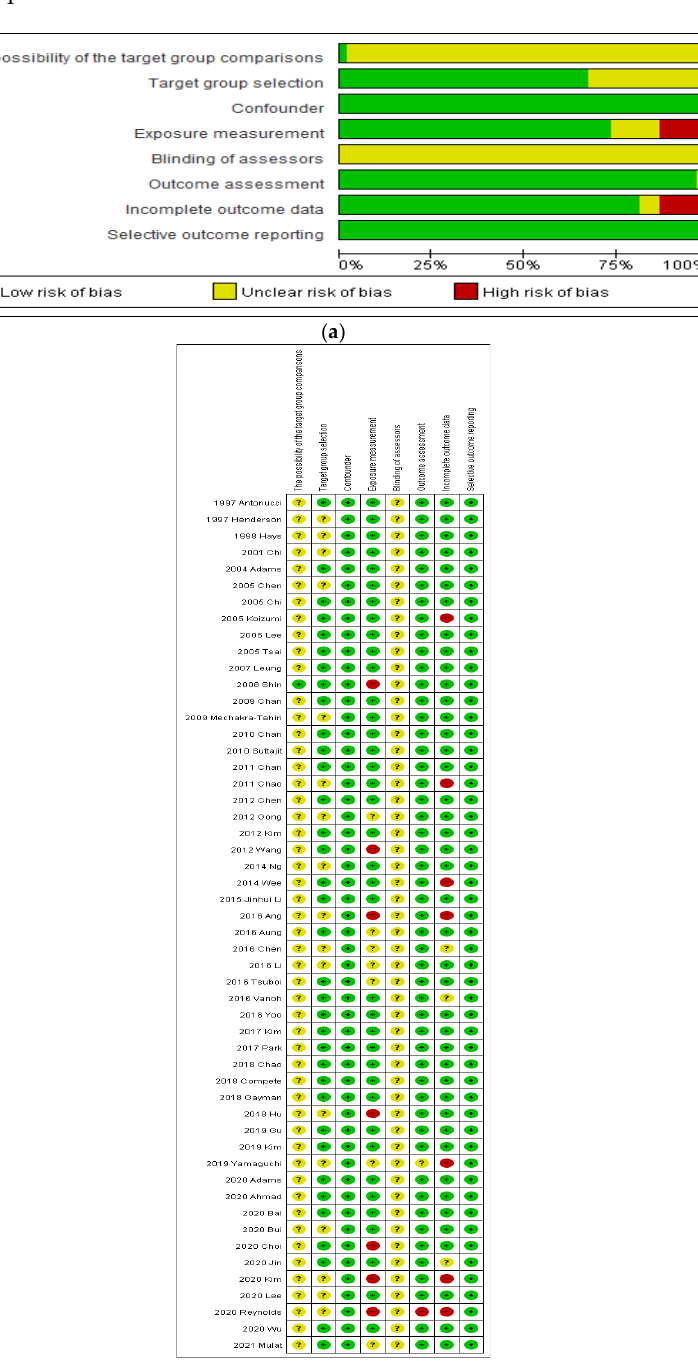
Figure 2. Quality assessment ( a ) Risk of bias graph; ( b ) Risk of bias